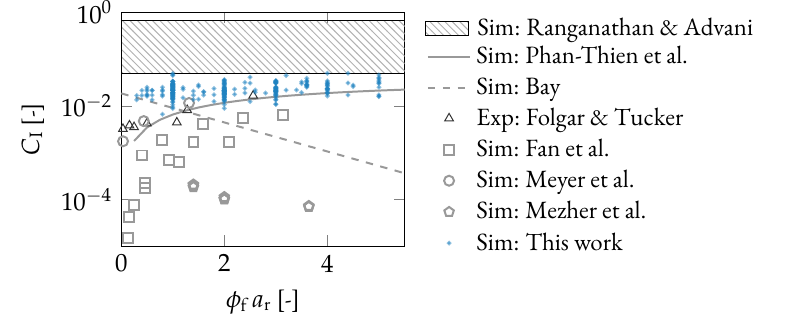
Figure 10. Literature data of Figure 2 shown in gray with an additional blue layer showing the FT parameters of this